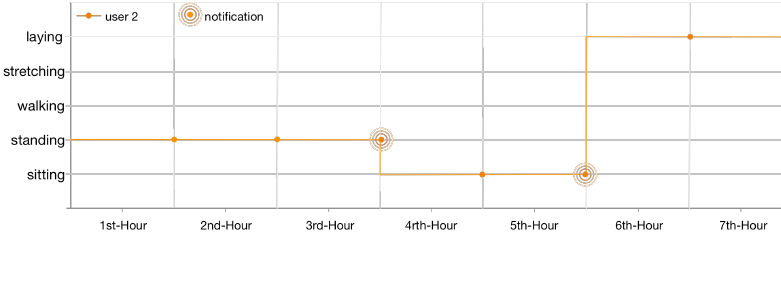
Figure 13. User 2, 7 h